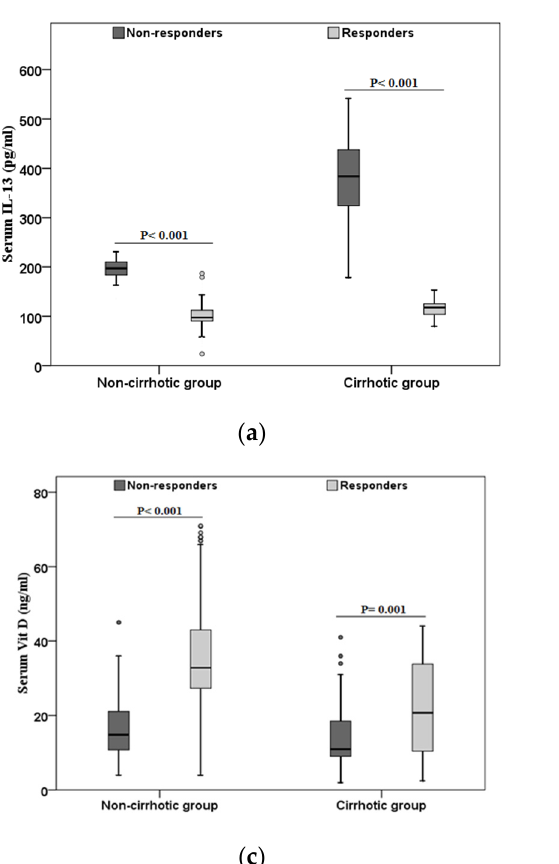
Figure 1. Comparison between laboratory parameters in different patients’ groups. Comparing the laboratory parameters between the cirrhotic and non-cirrhotic patients according to the therapy response ( a ): IL-13. ( b ): miRNA-135a. ( c ): Vit D. Responders are represented as light grey and non-responders are represented by dark grey.